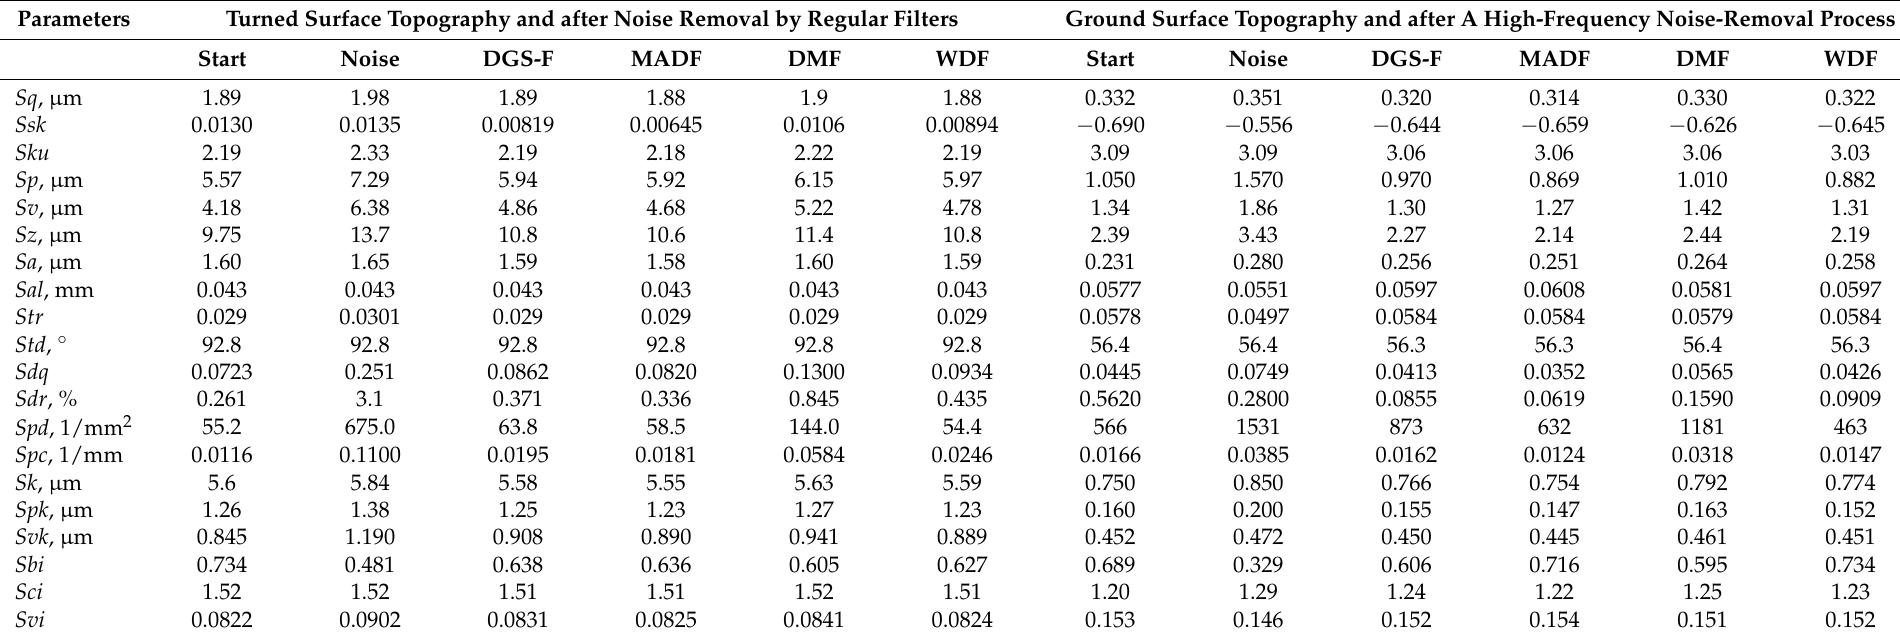
Table 4. Surface texture parameters calculated for turned and ground surface before and after noise modeling and reduction by commonly used filters.